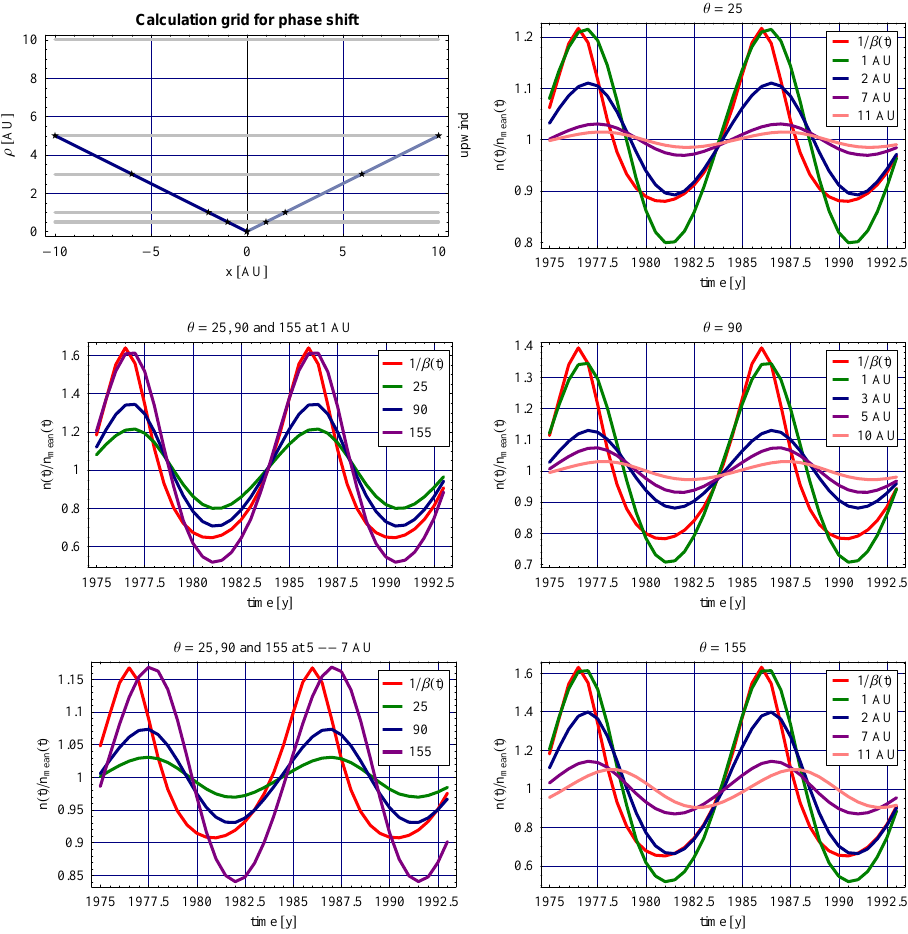
Fig. 7. Dependence of phase shift between time variations of the helium ionization rate and resulting deviations of helium density from the mean value. Upper left panel: calculations grid. The horizontal axis is the upwind – downwind direction, upwind is to the right. The vertical axis is the ρ coordinate in the cyllindric reference system. The intersection of the horizontal gray lines with the blue slant lines, marked with asterisks, are places where calculations were made marked as θ = 25 ◦ and θ = 155 ◦ . Additionally, the calculations were performed for the intersection of the crosswind direction θ = 90 ◦ with the gray lines. In the remaining panels: the red line is appropriately rescaled lifetime against ionization T (t)/T mean scaled to the mean time against ionization ( T (t) = 1 /β (t) ), presented here for reference of the phase of the ionization rate. In the left-hand column, middle and lower panels: phase shifts of the deviations of helium density from the solar-cycle mean are shown for the 25, 90 and 155 ◦ off apex at 1 AU (middle) and 5 AU from the Sun (lower). Right hand column: comparison of the phase shifts at various heliocentric distances at 25 (upper), 90 (middle) and 155 ◦ (lower panel) from the upwind direction at various heliocentric distances: the effect of the increase in the phase shift with the heliocentric distance and its negligible dependence on the offset angle is